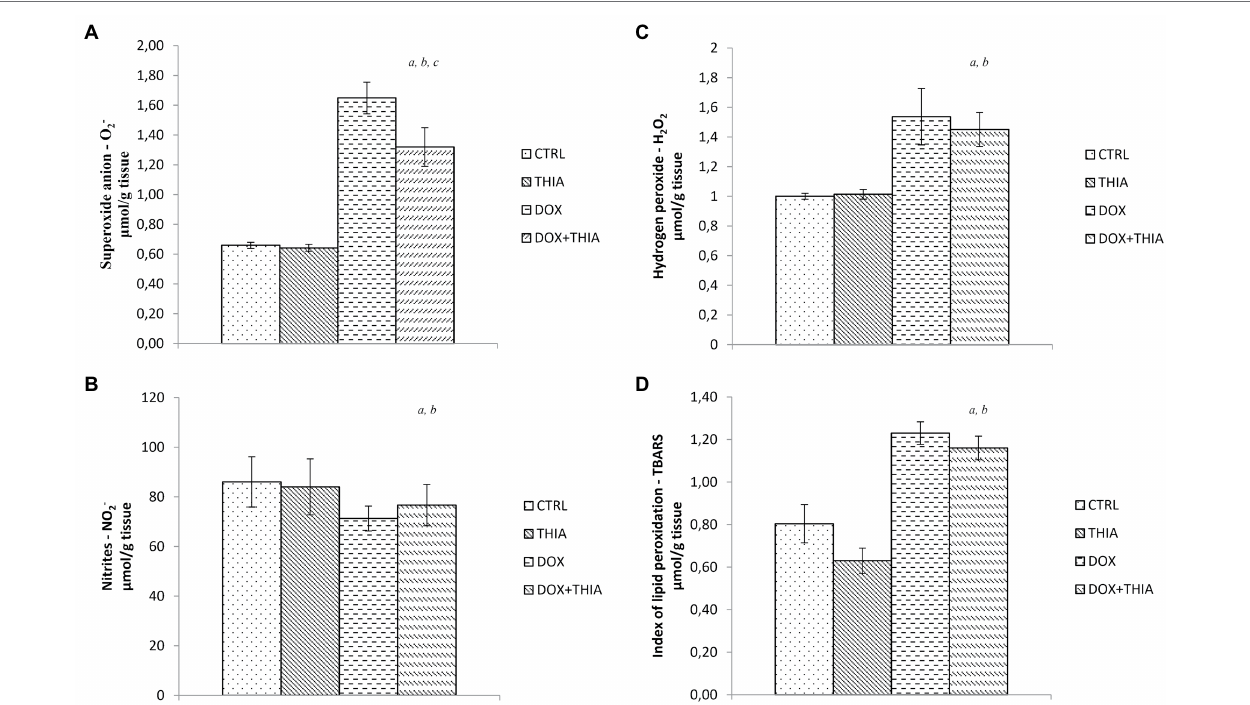
FIGURE 1 | Changes in the heart tissue pro-oxidative parameters of O 2 − (A) , hydrogen peroxide (H 2 O 2 ; B ), nitrites (NO 2 − ; C ), and thiobarbituric acid (TBA) reactive substances (TBARS; D ) in the control (CTRL), thiamine intraperitoneally (THIA), doxorubicin (DOX), and DOX + THIA groups. Values are presented as means ± SEM. a p < 0.05 compared with the normal CTRL group; b p < 0.05 compared with the THIA group; c p < 0.05 compared with the DOX group; and d p < 0.05 compared with the DOX + THIA